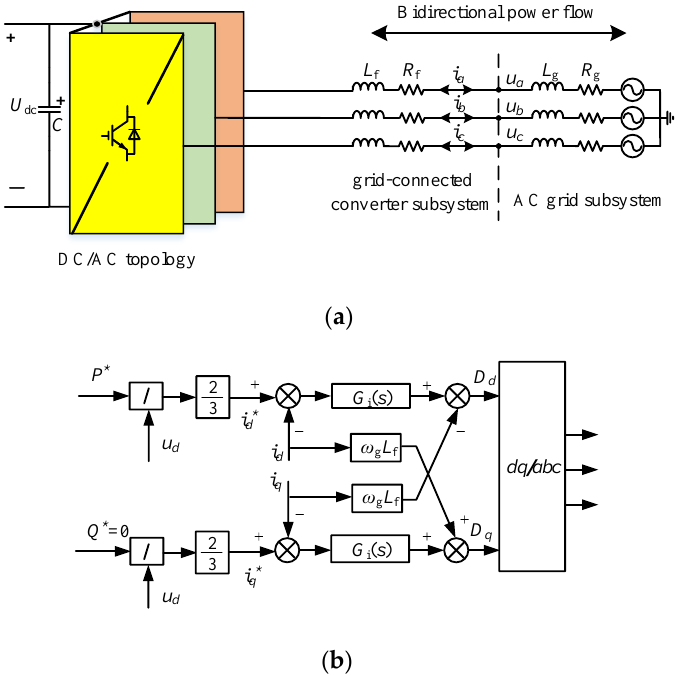
Figure 2. Grid-connected converter system. ( a ) Topology; ( b ) control unit under conventional direct power control.